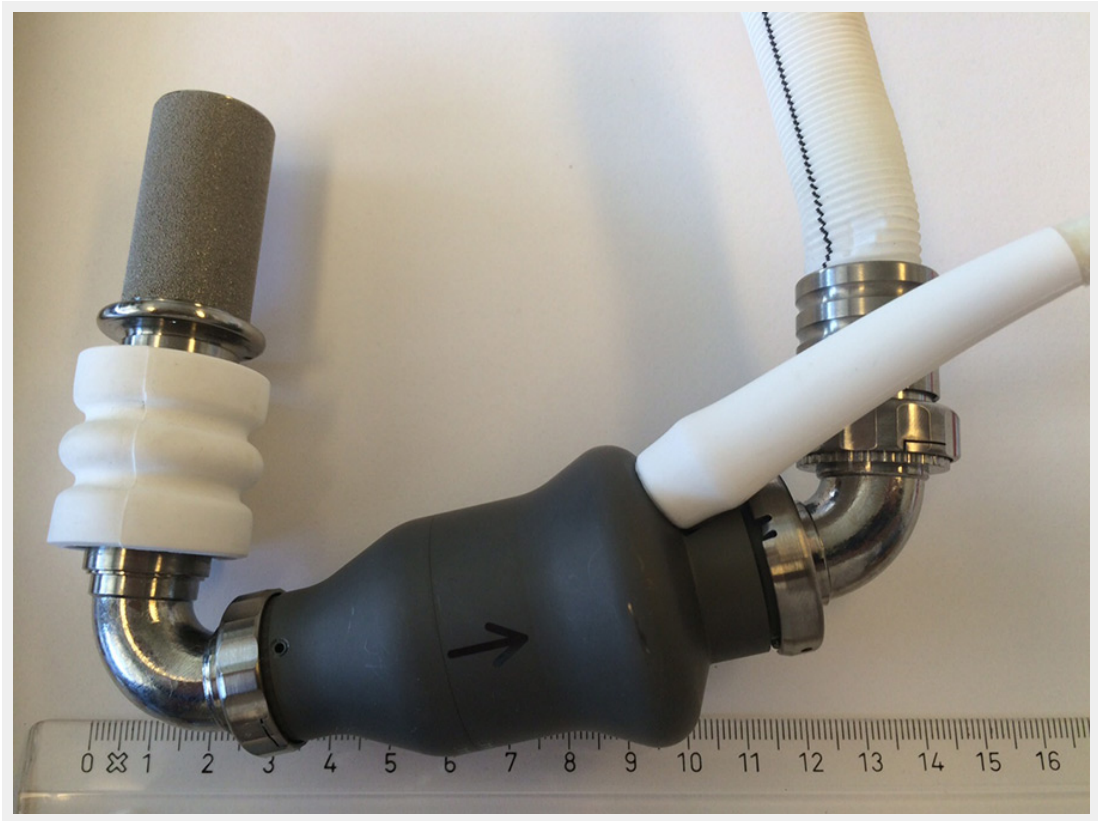
The HeartMate II (Thoratec Corporation, Pleasanton, California, USA) is a continuous flow axial pump with a magnetically activated impeller. It weighs 400 g and provides up to 10 l/min flow. It is the only ventricular assist device for destination therapy approved by the US Food and Drugs